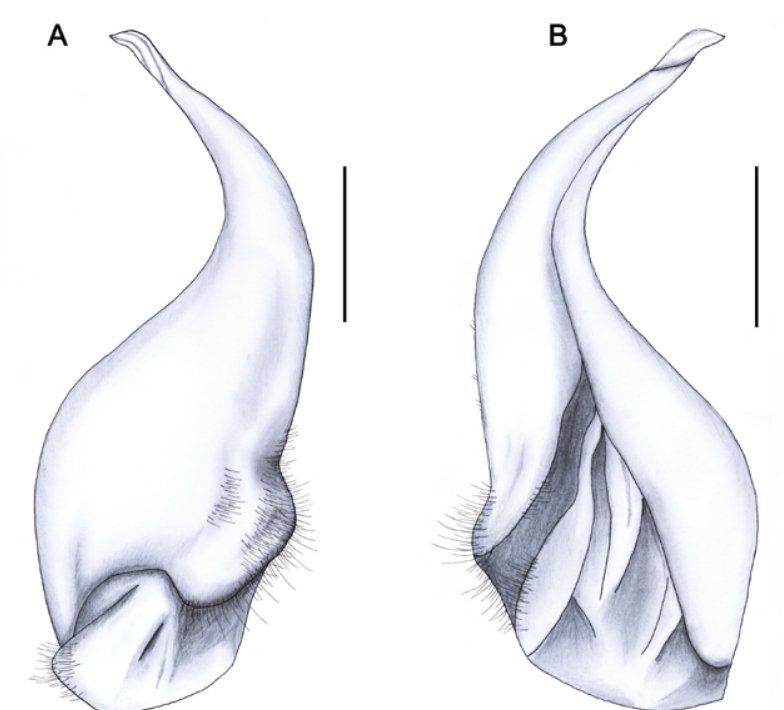
Figure 3. Mekhongthelphusa menglongensis sp. nov., holotype male (35.1 × 30.4 mm) (NNU 16C-MM01). A , G1 dorsal view; B , G1 ventral view. Scale bars = 1